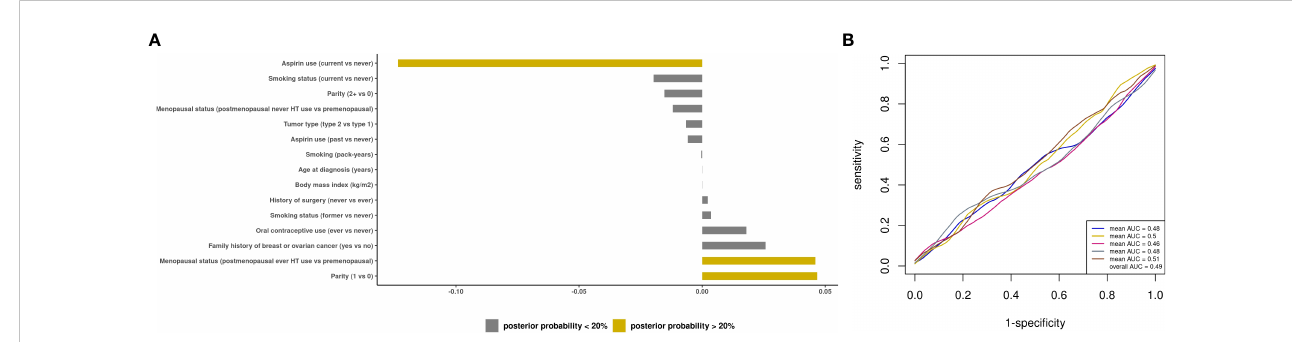
FIGURE 3 Prediction modeling of optimal debulking status using epidemiologic and clinical predictors. Average posterior means and associated average posterior probabilities of epidemiologic and clinical predictors being selected in the fi nal prediction model of optimal debulking status and area under the curve (AUC) of the prediction models using Bayesian model averaging among invasive epithelial ovarian cancer cases (n=593) in NHS/NHSII/NEC. We assessed the posterior probability of 11 predictors for possible selection in the fi nal model and conducted fi ve 5-fold cross-validations. The bar chart (A) presents the average posterior mean across the 25 models that were run in total; grey bars denote predictors with average posterior probabilities <20% and yellow bars denote predictors with average posterior probability ≥ 20%. (B) presents the fi ve average AUCs from the fi ve 5-fold cross-validations and in the legend overall AUC, which is the average of the average AUCs from the 5-fold CV, is presented. Type 2 tumors include high-grade serous or poorly differentiated, Transitional/Brenner, Carcinosarcoma, high grade mixed